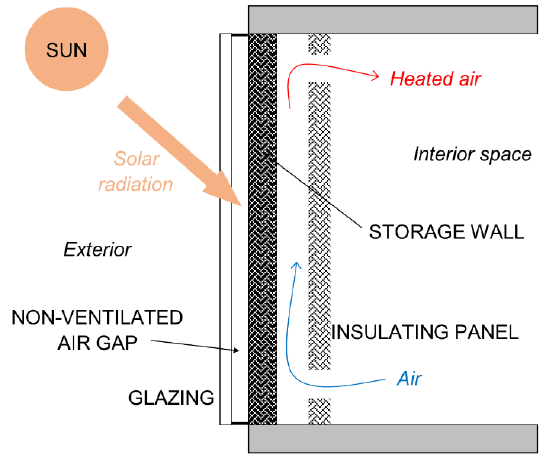
Figure 4. Schematic of a Trombe wall with incorporated PCM.